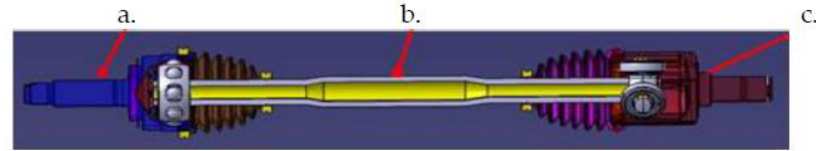
Figure 2. Driveshaft in general detail.